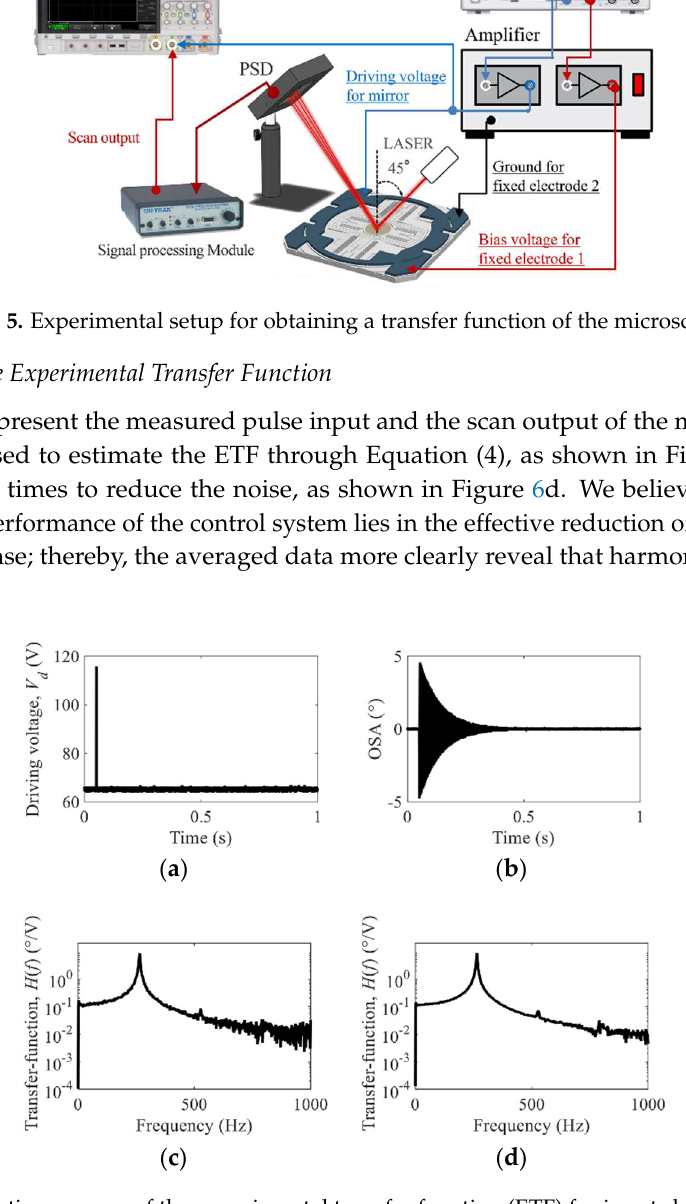
Figure 6. Estimation process of the experimental transfer function (ETF) for input shaping: ( a ) input impulse in the time domain ( V d : 55 V, V b /2: 65 V, pulse width 500 μs), ( b ) output response in the time domain, ( c ) an ETF, and ( d ) a ten-times averaged ETF revealing the second and third harmonics.